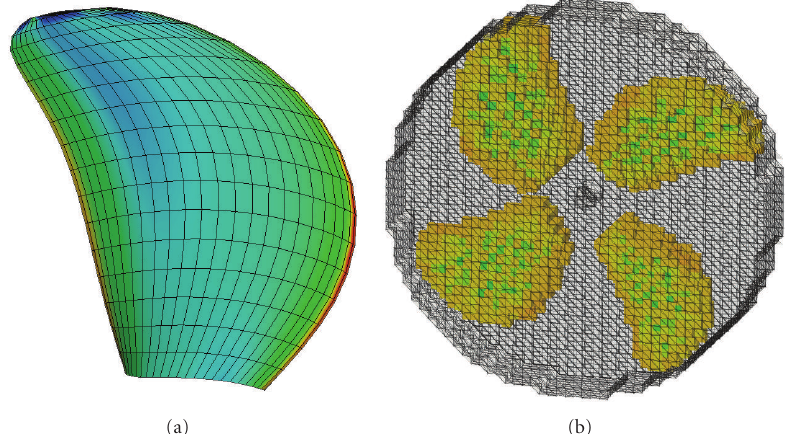
Figure 13: Numerical grid and resulting pressure distribution for the BEM simulation (a). FV grid in the propeller disc (b). Only cells at the actual blade positions contain body forces (colored).